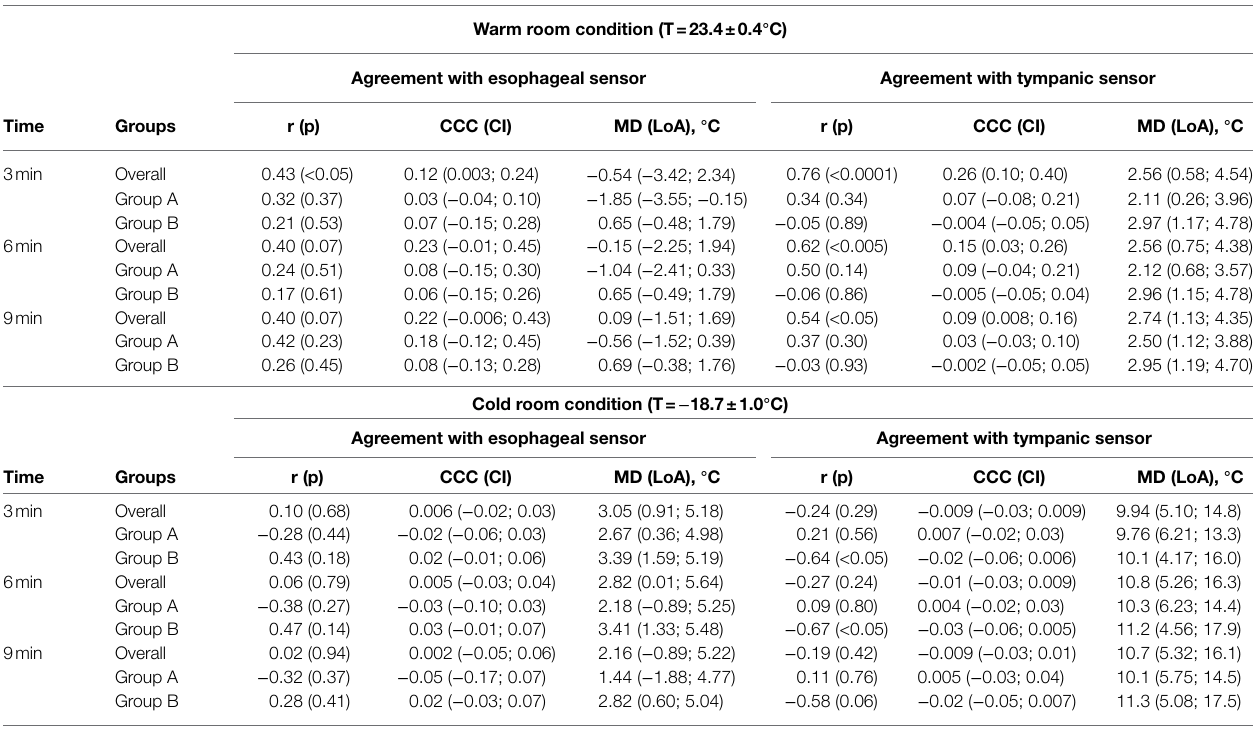
TABLE 2 | Agreement between the double sensor, esophageal, and tympanic sensors at different time points, room temperature settings, and study